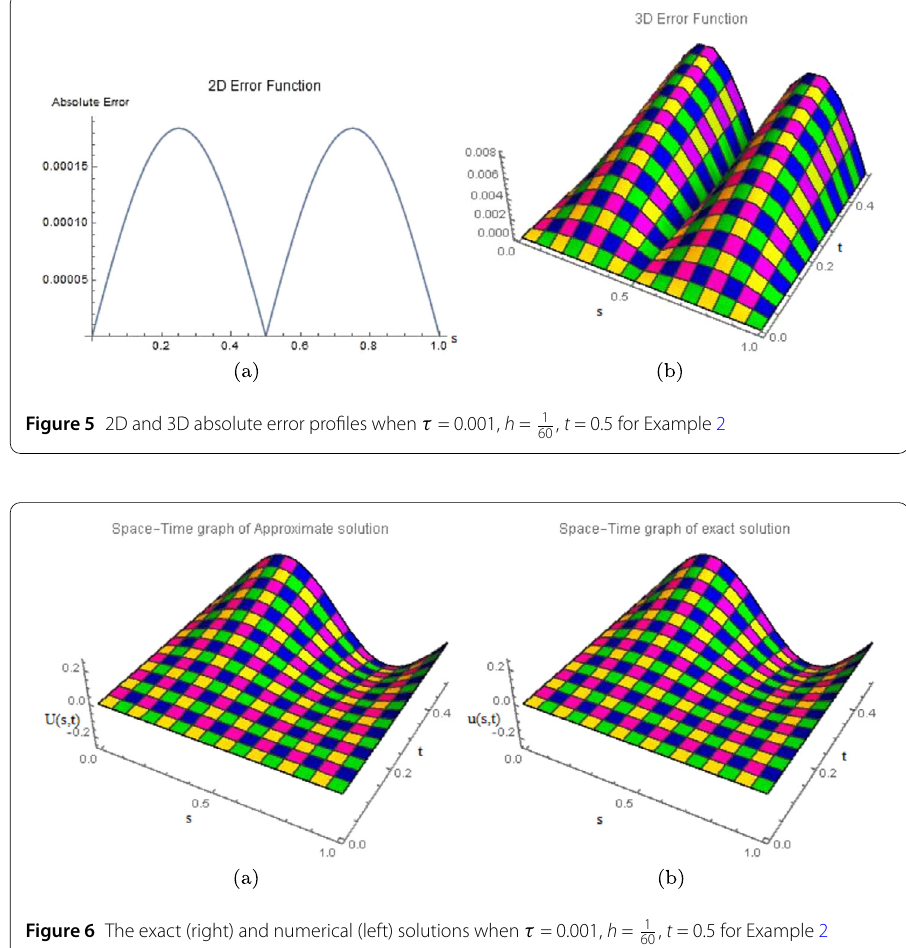
Table 3 Comparison of error norms when γ = 0.9, h = 1 M